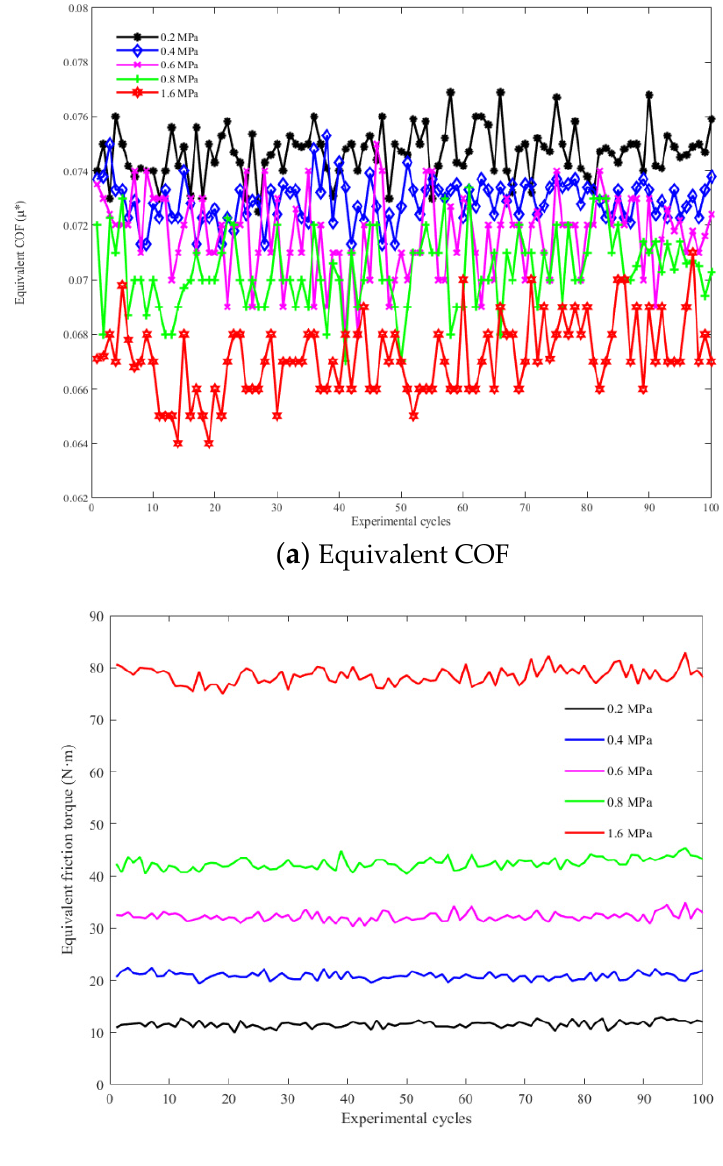
Figure 11. Two-friction pair system.